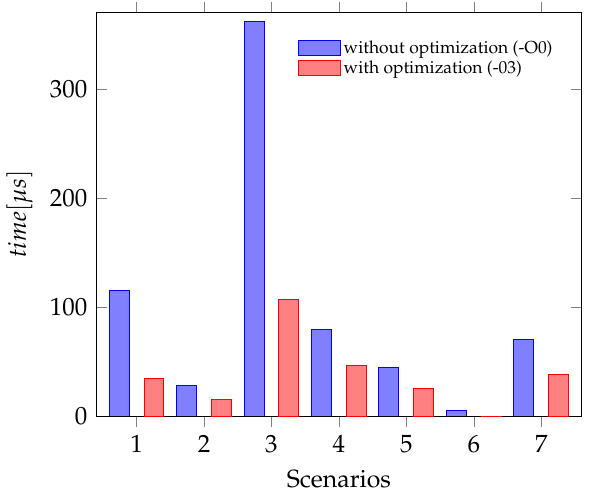
Figure 12. Timing behavior with and without compiler optimization (Scenario ID in Tables 3 or 4).